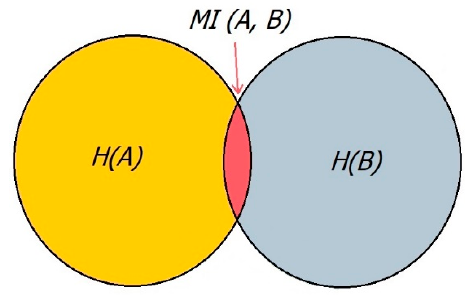
Figure 3. The concept of mutual information.